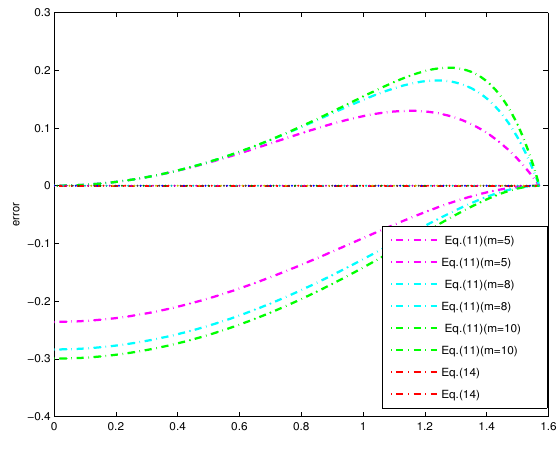
Figure 7. Error plots between sinc(x) and the polynomial bounds of Equations (11) and